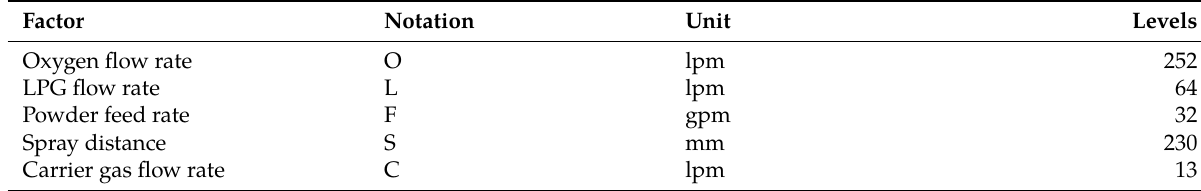
Table 2: Optimised process parameters of HVOF spraying. Factor Notation Unit Levels Oxygen flow rate O LPG flow